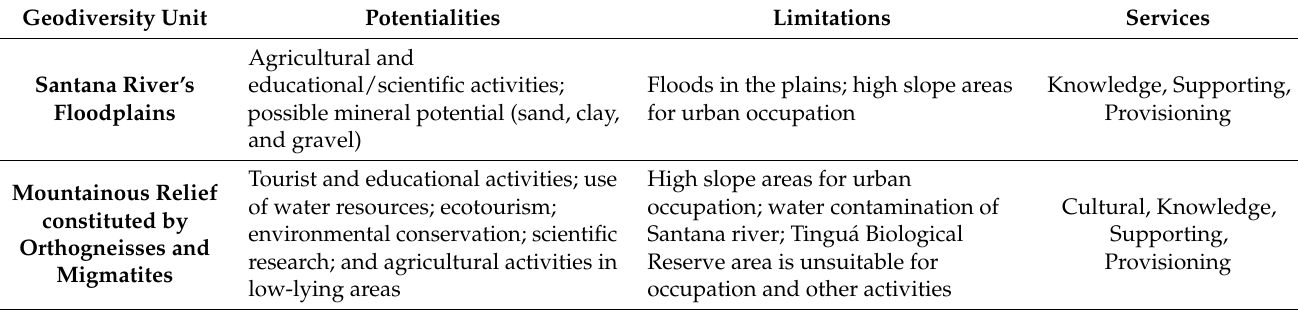
Table 2. Potentialities of and limitations to the use of the geodiversity units and their correspond- ing